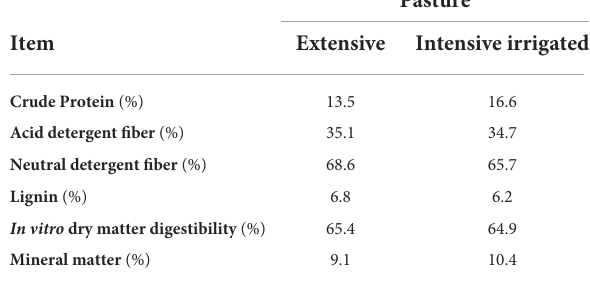
TABLE 1 Bromatological composition of the pastures (DM